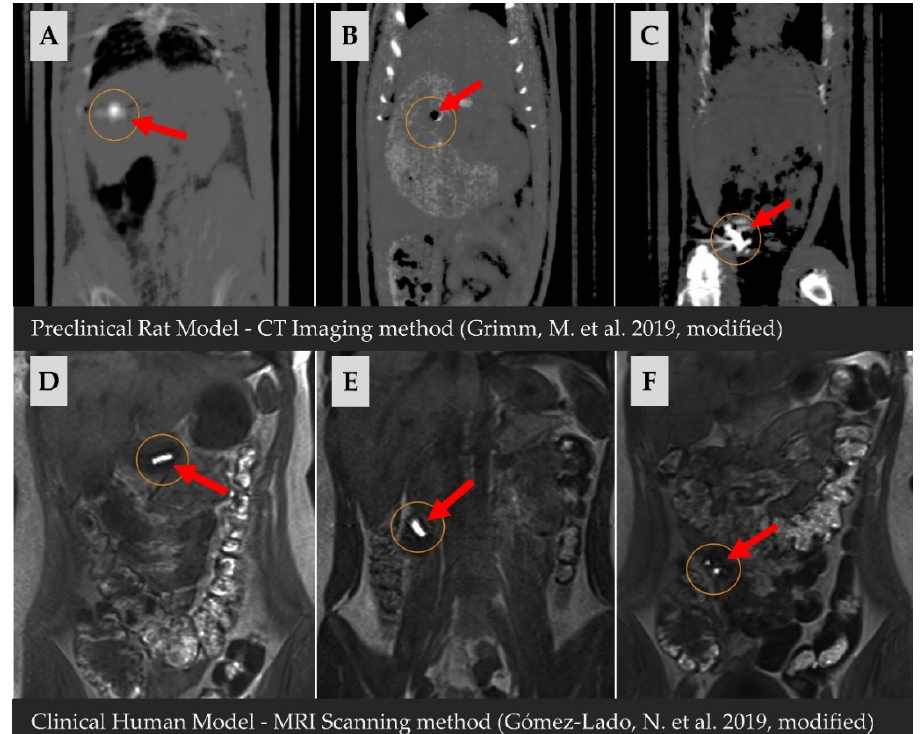
Figure 3. Documentation of the behavior of the enteric capsule after administration into the organism with two methods (MRI; CT) [75,108]; preclinical study performed on multiple rat models (differences in transit time could occur): ( A )—capsule in the stomach after administration, ( B )—disintegrated capsule in the stomach after 540 min, ( C )—disintegrated capsule in caecum after 180 min; clinical study performed on one human model: ( D )—capsule in the stomach after 5 min, ( E )—capsule in ileum after 150 min, ( F )—disintegrated capsule in ileum after 210 min. Reprinted from Eur. J. Pharm. Sci., 129. Grimm, M.; Ball, K.; Scholz, E.; Schneider, F.; Sivert, A.; Benameur, H.; Kromrey, M.L.; Kühn, J.P.; Weitschies, W. Characterization of the Gastrointestinal Transit and Disintegration Behavior of Floating and Sinking Acid-Resistant Capsules Using a Novel MRI Labeling Technique, 163–172, Copyright (2019), with permission from